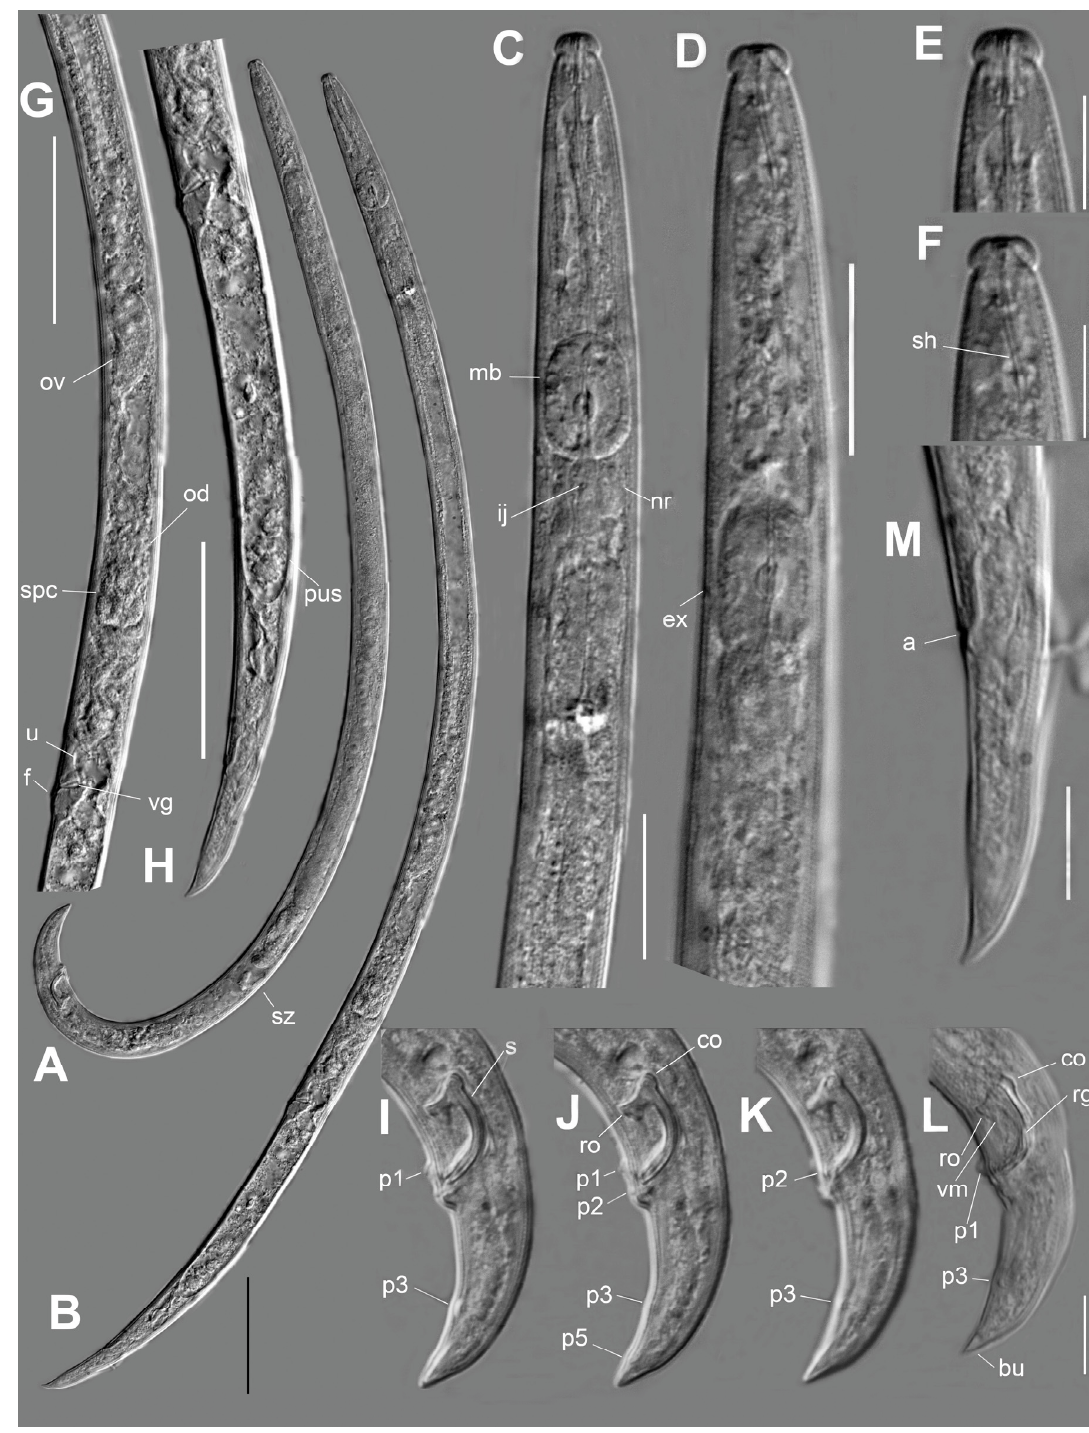
Figure 1. Bursaphelenchus zvyagintsevi sp. n. ( A )—male. ( B )—female. ( C )—female anterior end. ( D )—male anterior end. ( E )—female lip region. ( F )—male lip region. ( G )—female anterior genital